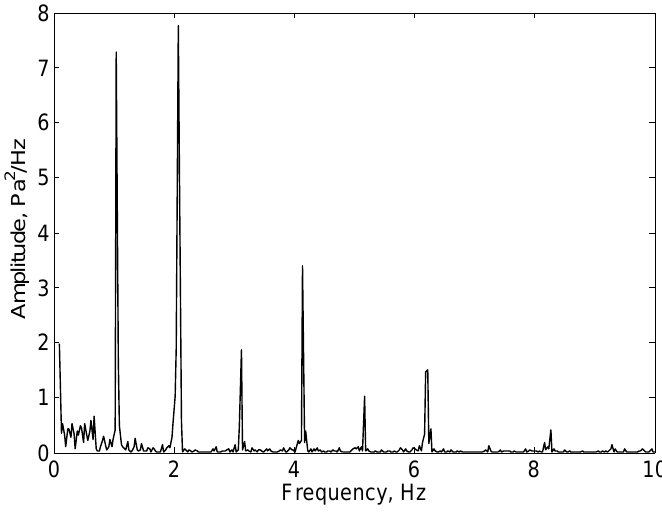
Figure 5. Power spectral density of the ∆ P signal recorded during walking indoors at 2 Hz f . From the figure it is possible to identify spectral peaks related to step and step stride